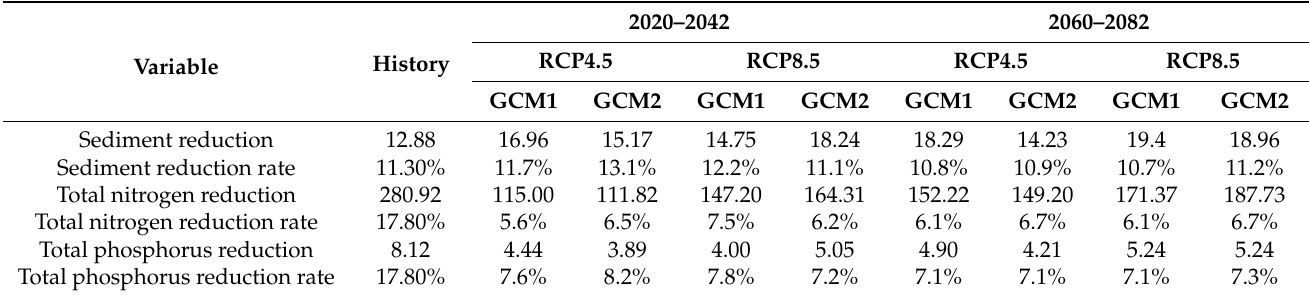
Table 7. Reduction of NPS pollution loads by land use change of ecological protection with the consideration of spatial allocation